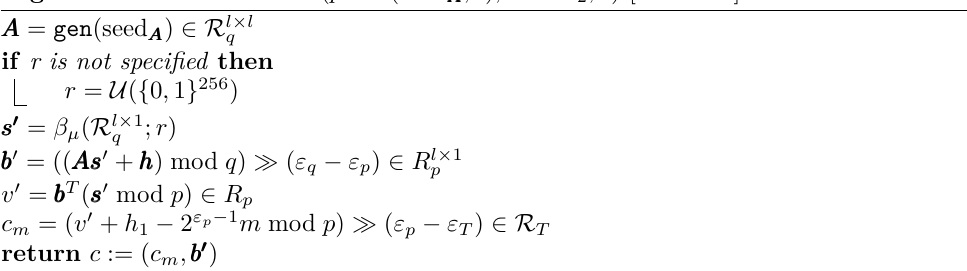
Algorithm 2 Saber . PKE . Enc ( pk = ( seed AAA ,bbb ) , m ∈ R 2 ; r ) [DKRV19]